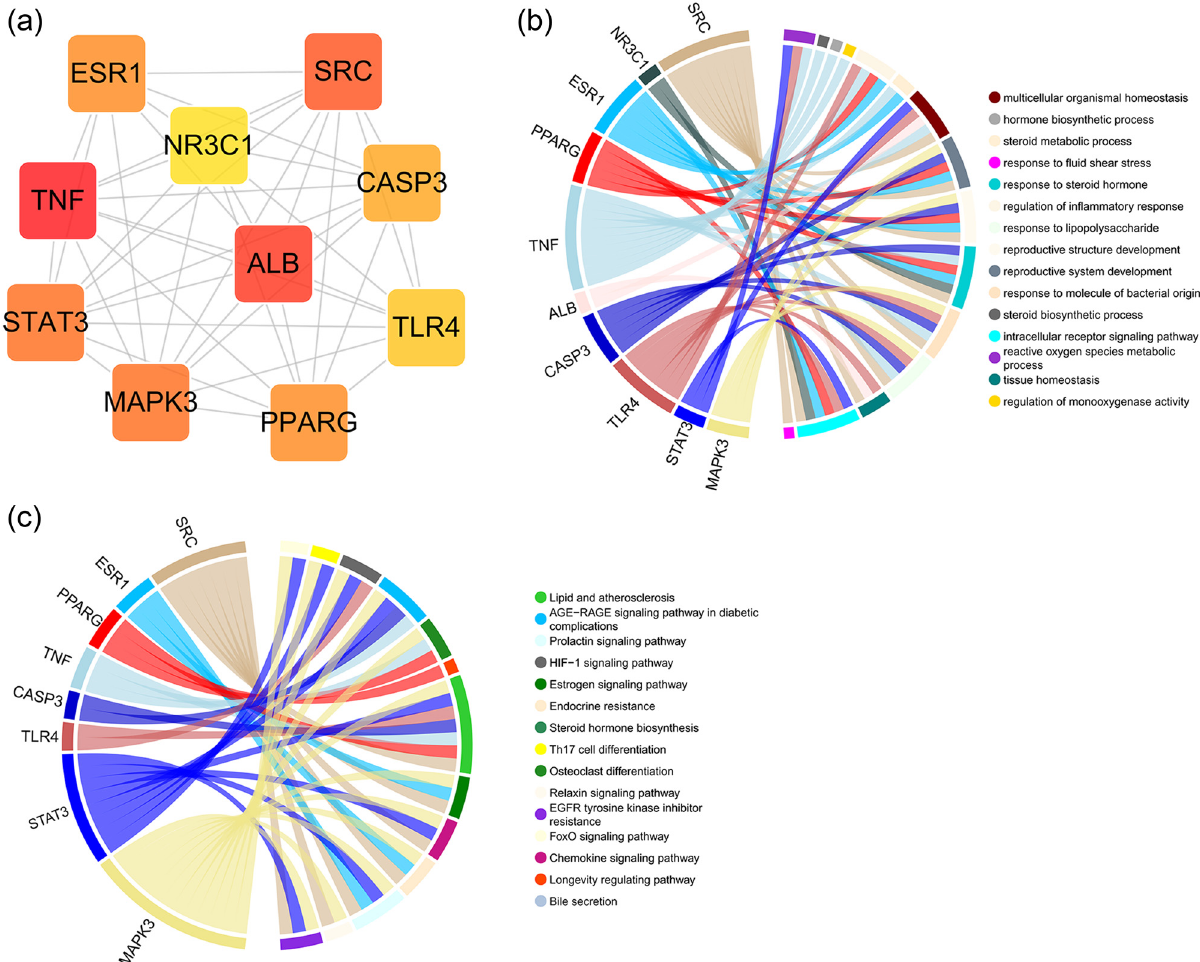
Figure 3: Top 10 hub targets and their enrichment analysis. ( a ) The subnetwork constructed by the top 10 hub proteins with higher degrees in the PPI network. ( b ) The association of hub proteins with the top 15 GO BP terms. ( c ) The association of hub proteins with the top 15 KEGG